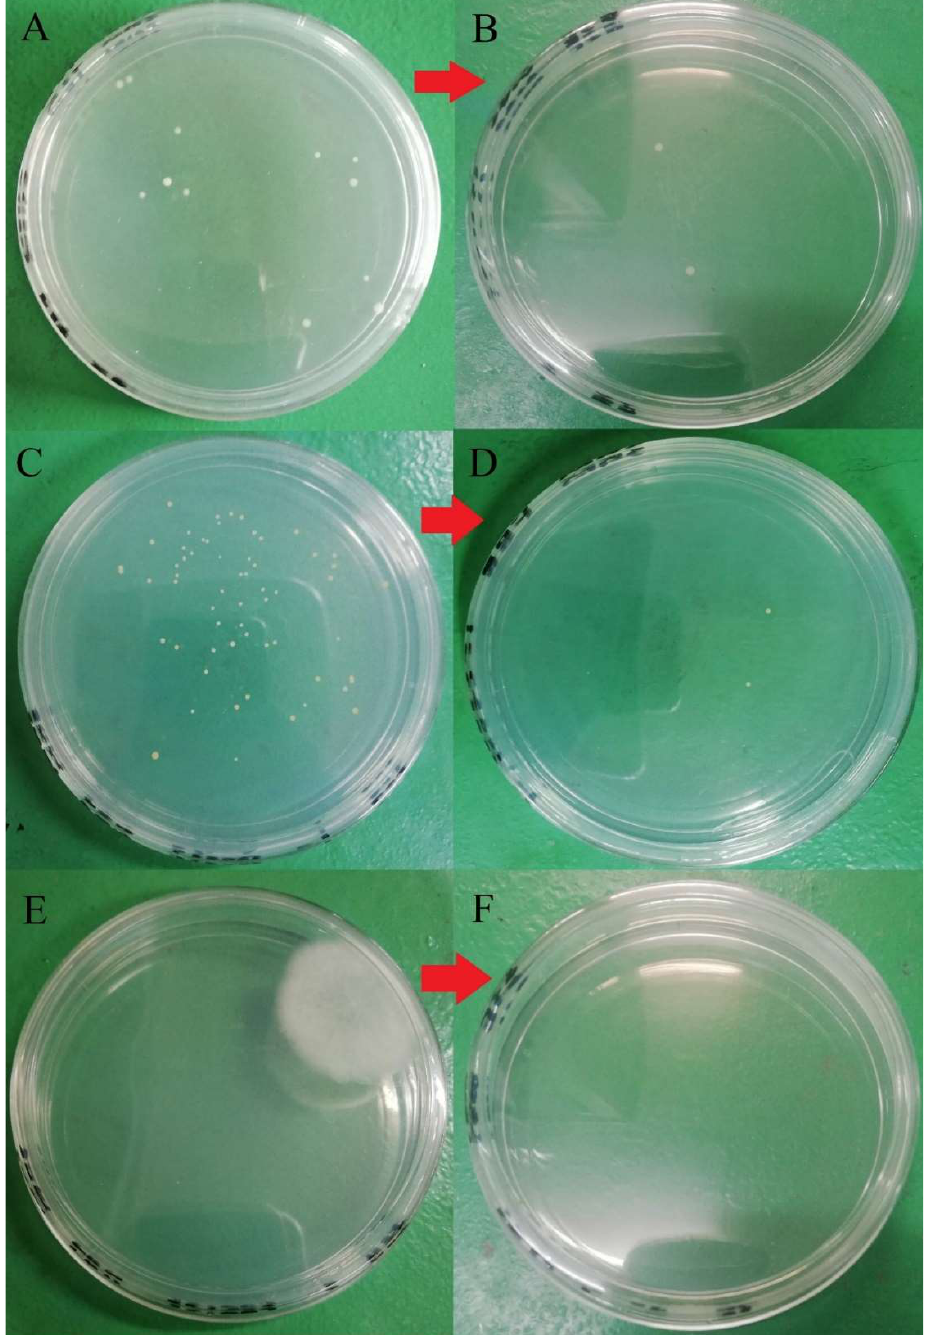
Figure 7. Microbial load before and after washing with 100 ppm quat sanitizer for 5 min. ( A ) Total aerobic mesophilic bacteria at a dilution of 10 5 before washing; ( B ) total aerobic mesophilic bacteria at a dilution of 10 3 after washing; ( C ) yeast population at a dilution of 10 1 before washing; ( D ) yeasts population at a dilution of 10 1 after washing; ( E ) molds population at a dilution of 10 1 before washing; ( F ) molds population at dilution 10 1 after washing.